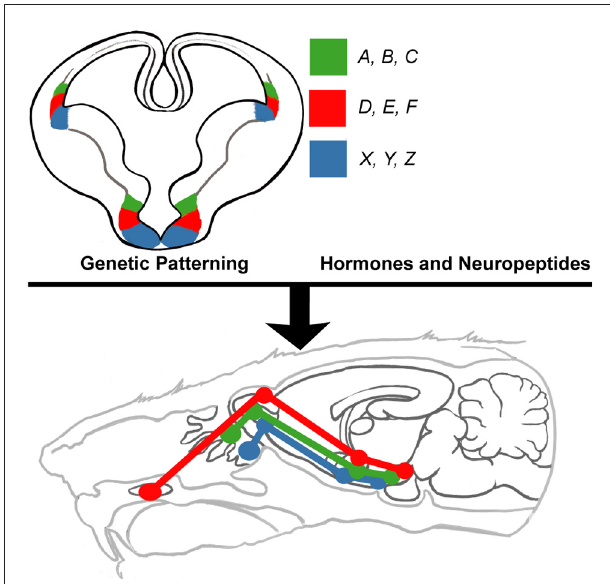
FIGURE 5 | Proposed model of innate limbic circuit development. In this model, combinations of select subsets of transcription factors (e.g., A, B, C) that endow neuronal identity also encode genes required for formation of connections (e.g., cadherins) with neurons located in other parts of the brain. Neurons destined to connect are derived from progenitors that express the same sets of transcription factors. Thus, developmentally regulated transcription factors are the driving force behind setting up complex circuits. This pre-patterned circuitry is then extensively shaped and modified by the actions of select hormones (e.g., testosterone and estrogen) and neuropeptides (e.g., oxytocin and